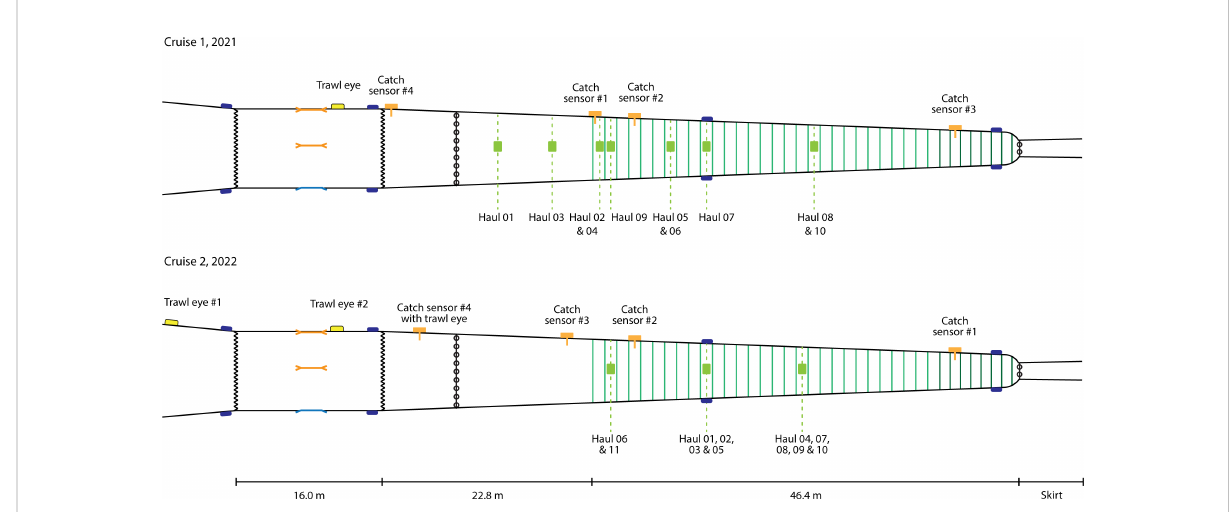
FIGURE 6 Positions on the codend of the depth triggered releaser and other instruments for cruises 1 (Top) and cruise 2 (bottom). Releaser positions for each haul in both cruises are shown in green (see also Table 2). Also shown are the relative positions of the “ Trawl-Eye ” echo-sounders (yellow), Catch Sensor units (orange) and depth-loggers